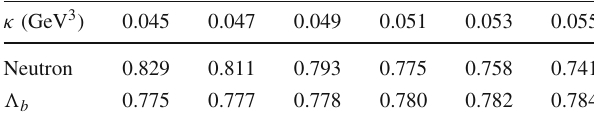
Table 1 The values of α sef f for the neutron and (cid:2) b